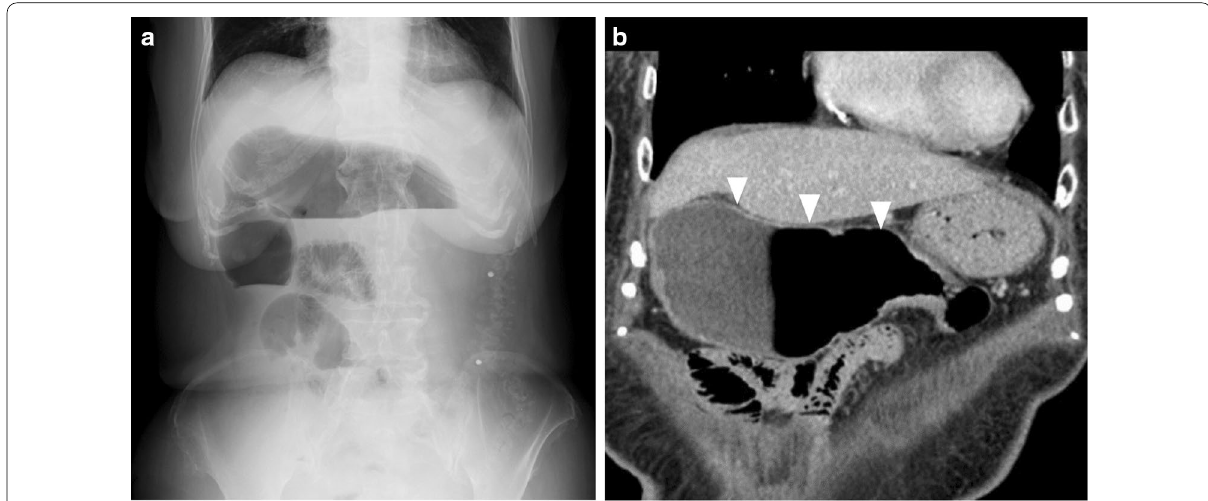
Fig. 2 Abdominal X-ray and contrast-enhanced computed tomography (CT). a X-ray shows massive colon gas niveau formation in the epigastric region. b Dilation of the cecum, ascending colon, and transverse colon proximal to the splenic flexure seen on the contrast-enhanced CT scan. No mechanical obstruction is present (arrowhead)